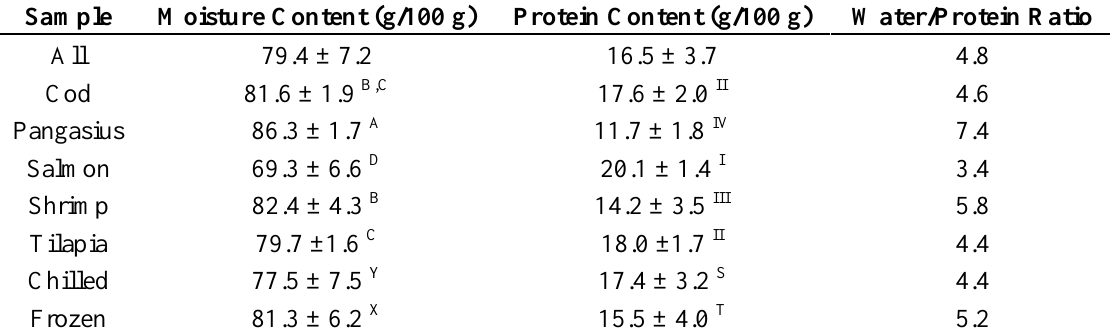
Table 2. Moisture contents, protein contents and water/protein ratios in various seafood samples presented for different groups (mean ± SD) 1